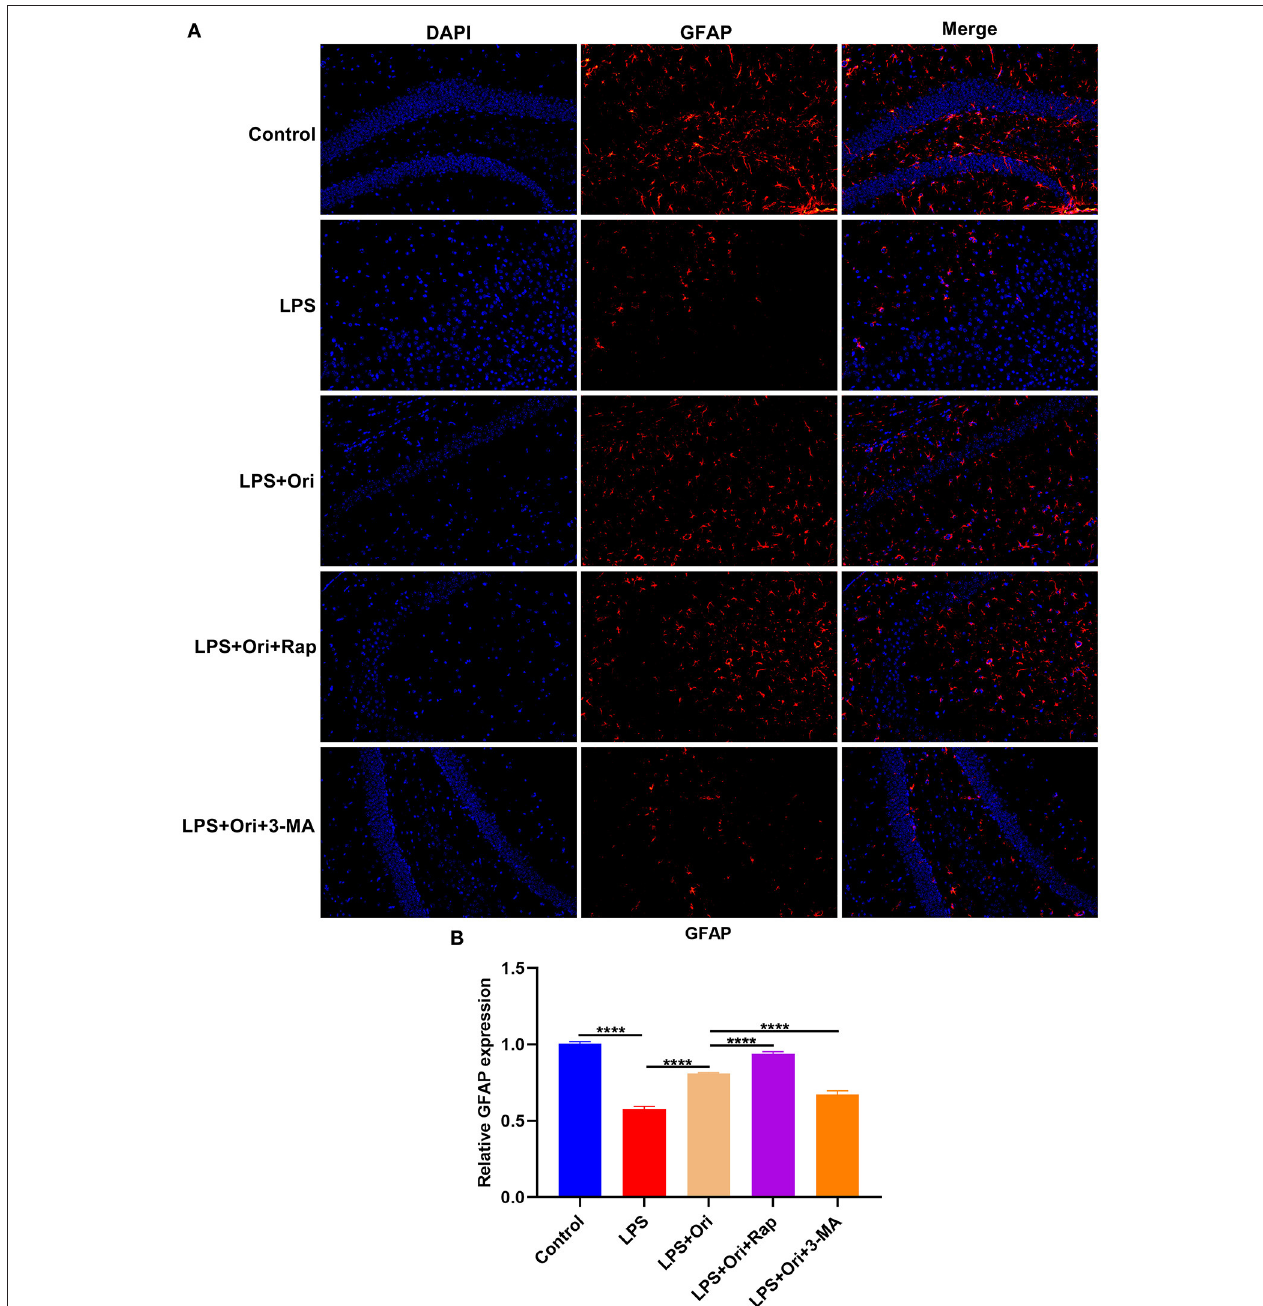
FIGURE 2 | Effects of Ori, autophagy agonist Rap and inhibitor 3-MA on astrocyte activation in the hippocampus of LPS-induced depression mouse models. (A) Representative IF staining of GFAP in the hippocampus in each group. Magnification, 200 × (50 µ m). (B) Quantification of GFAP expression according to the IF staining results. N = 6 each group. P values were calculated with ANOVA followed by Turkey’s post-hoc test. **** P <